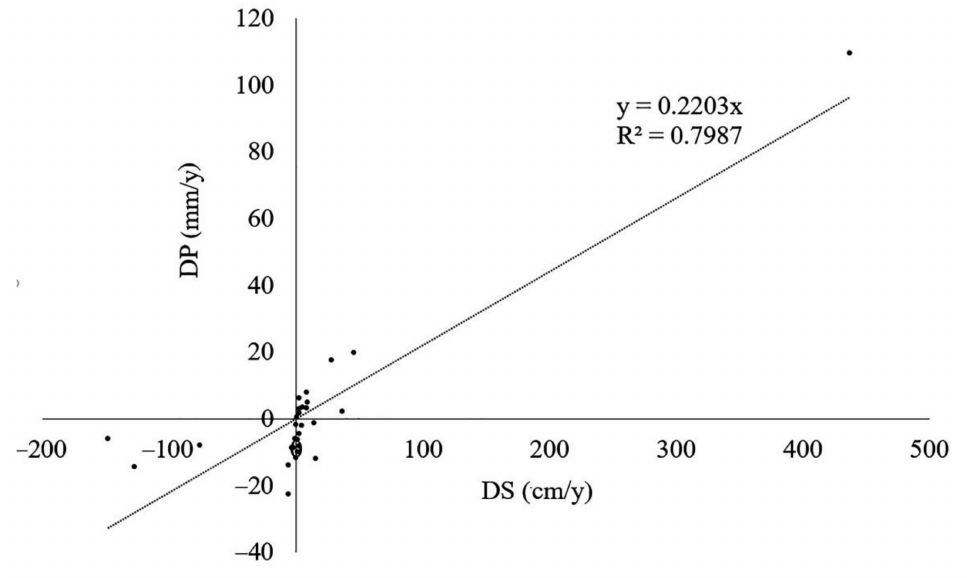
Figure 16. Correlation of DP and DS during snowfall